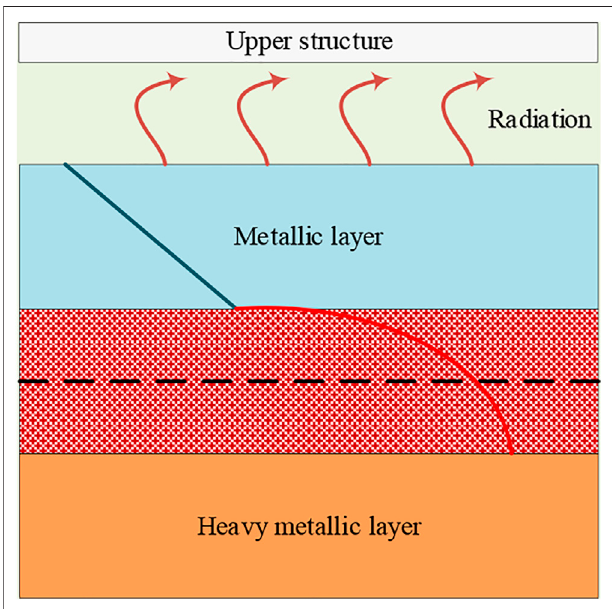
FIGURE 6 | Schematic diagram of temperature gradient in the solid oxide